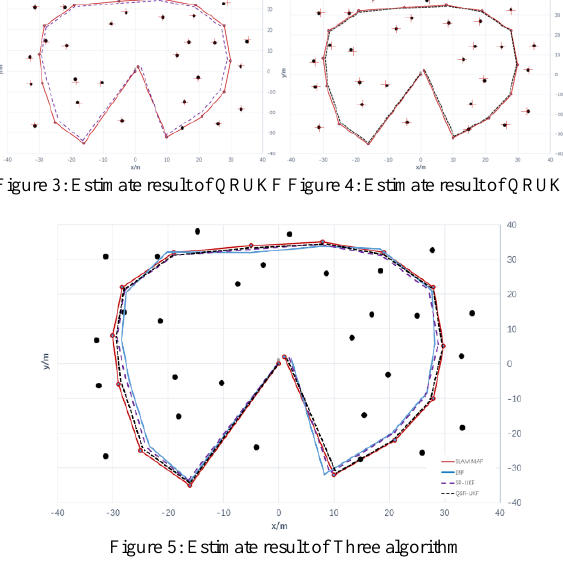
Figure 5: Estimate result of Three